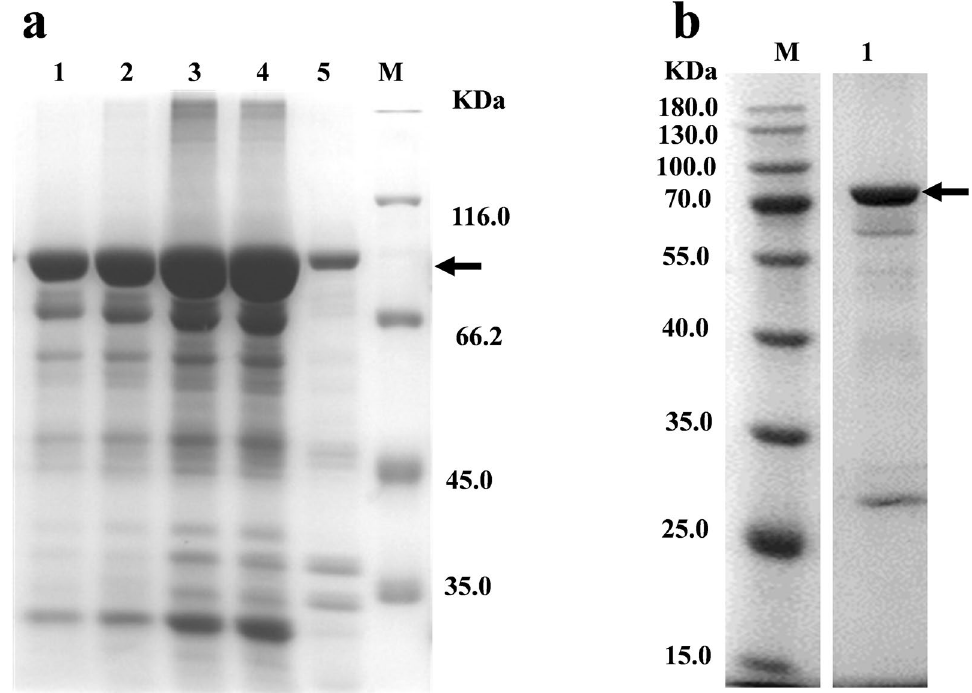
Fig. 2 Expression, and purification of recombinant bl-GBE a SDS-PAGE analysis of bl-GBE expressed as inclusion bodies in BL21 (DE3) . Lane M, Unstained Protein MW Marker; lanes 1–4, samples induced at 20 °C for 12, 24, 48, and 72 h, respectively; lane 5, uninduced control, b SDS-PAGE analysis of the purified recombinant bl-GBE protein. Lane M, unstained Protein MW Marker; lane1: purification sample of recombinant bl-GBE. The black arrow indicates the position of bl-GBE protein